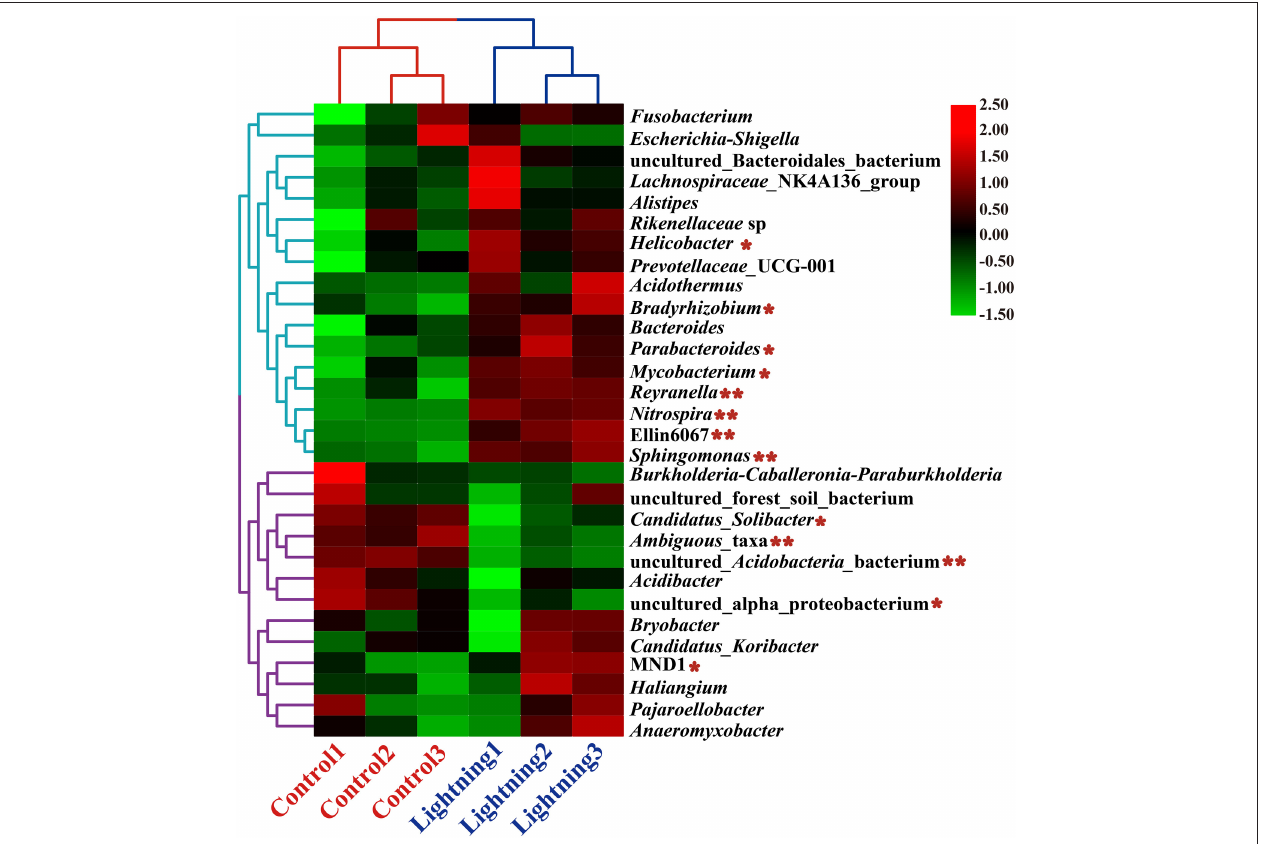
FIGURE 4 | Heat maps of the 30 genera with the highest relative abundance in rhizosphere soils of Pu-erh tea. The color block in the heat map from green to red indicates that the abundance of the sample increases gradually. Lighting represents a sample 10m from the lightning rod; Control indicates that the distance between the sample and the lightning rod is > 1,500m. *Indicates significant differences between different samples at the l0065vel of P < 0.05, while ** indicates significant differences between different samples at the level of P < 0.01.